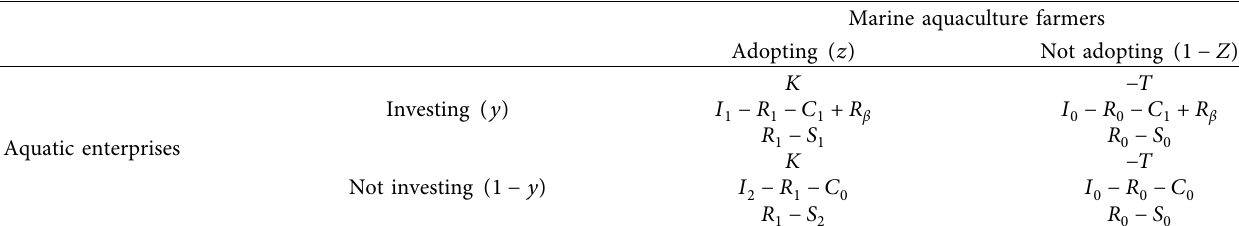
Table 2: Payment matrix of the tripartite evolutionary game without government